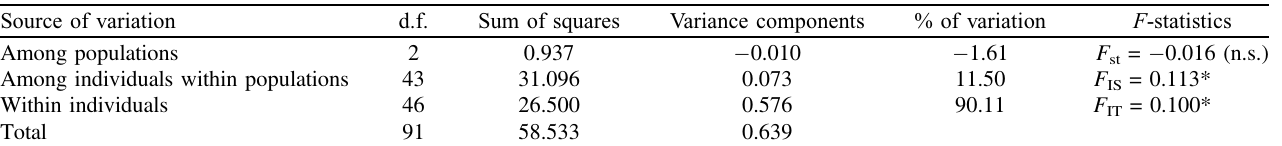
Table 2. AMOVA results for adult specimens of A. berlandi, collected from two individual hosts of Globicephala melas . Source of variation d.f. Sum of squares Variance components % of variation F -statistics Among populations 2 0.937 (cid:3) 0.010 (cid:3) 1.61 F st = (cid:3) 0.016 (n.s.) Among individuals within populations